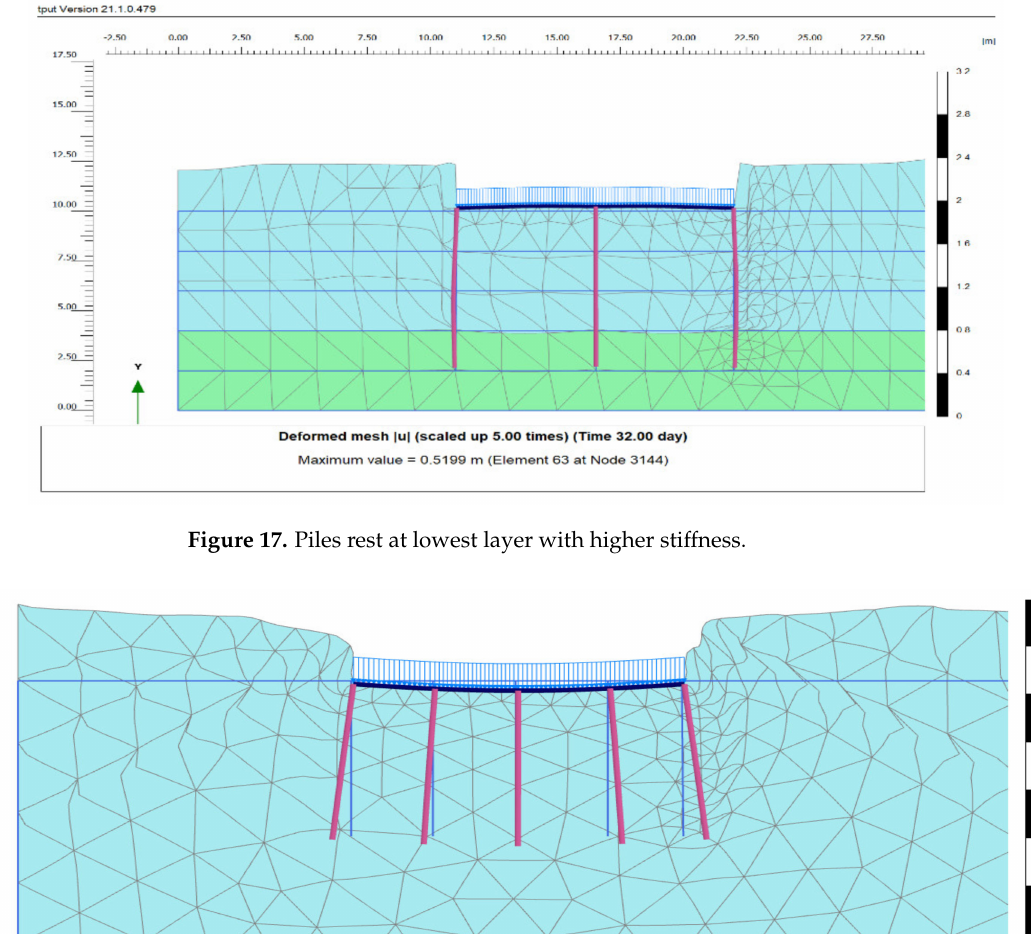
Figure 16. Effect of stiffness of lowest bottom layer on swelling.